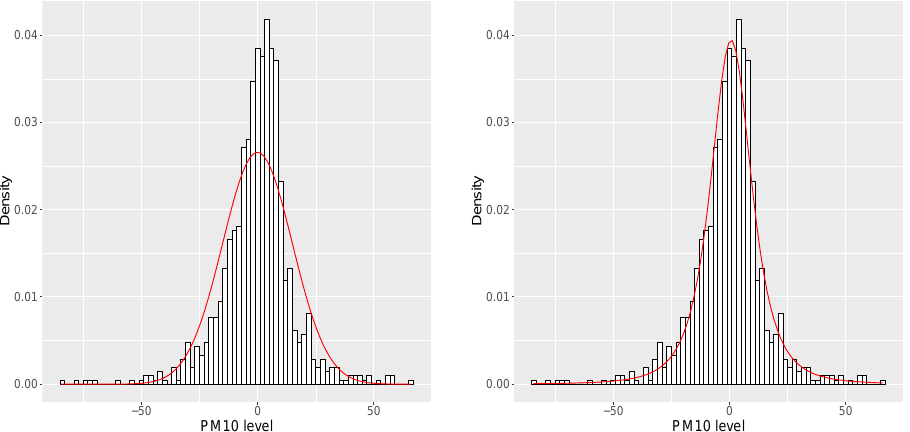
Figure 2. Fitting the normal ( left ) and t-distribution ( right ) on ∆ C( ∆ t) PM 10 values from Ljubljana, Slovenia for the period 2014–2016.